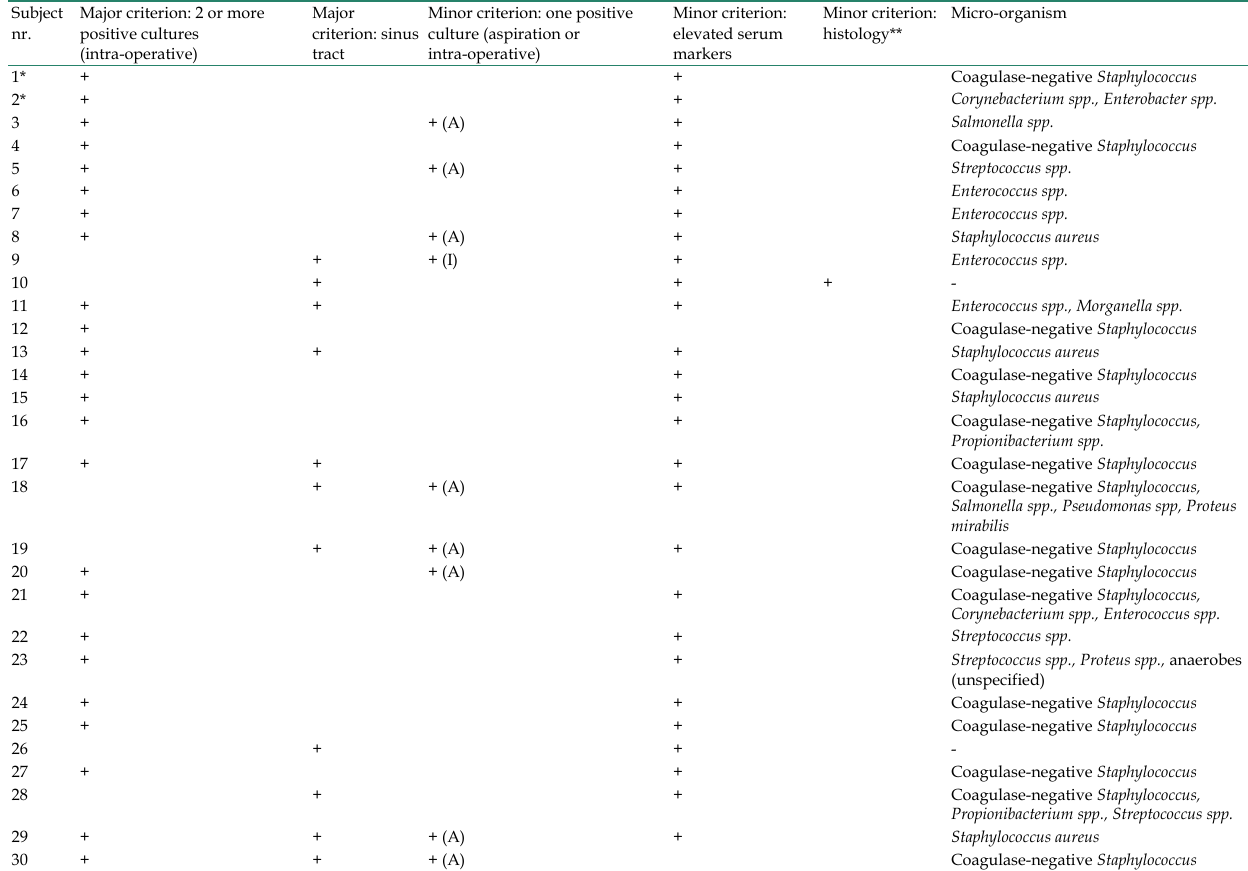
Table 2: Case characteristics and criteria for confirmation of PJI, according to definition. Subject Major criterion: 2 or more nr. positive cultures (intra-operative)